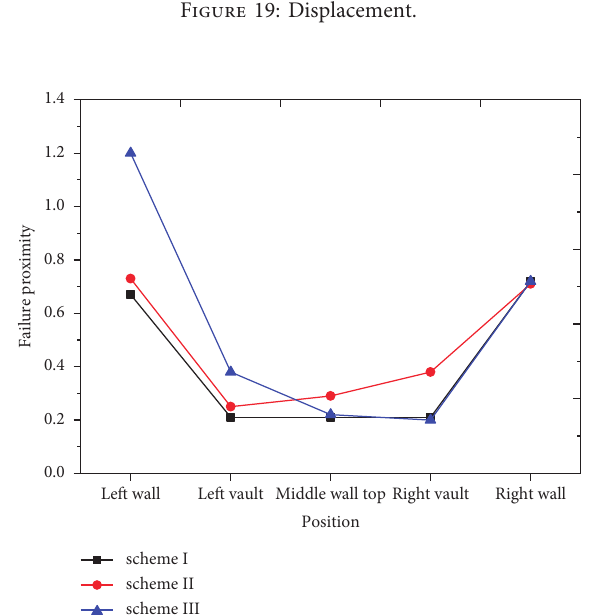
Figure 18: Failure proximity of scheme III.